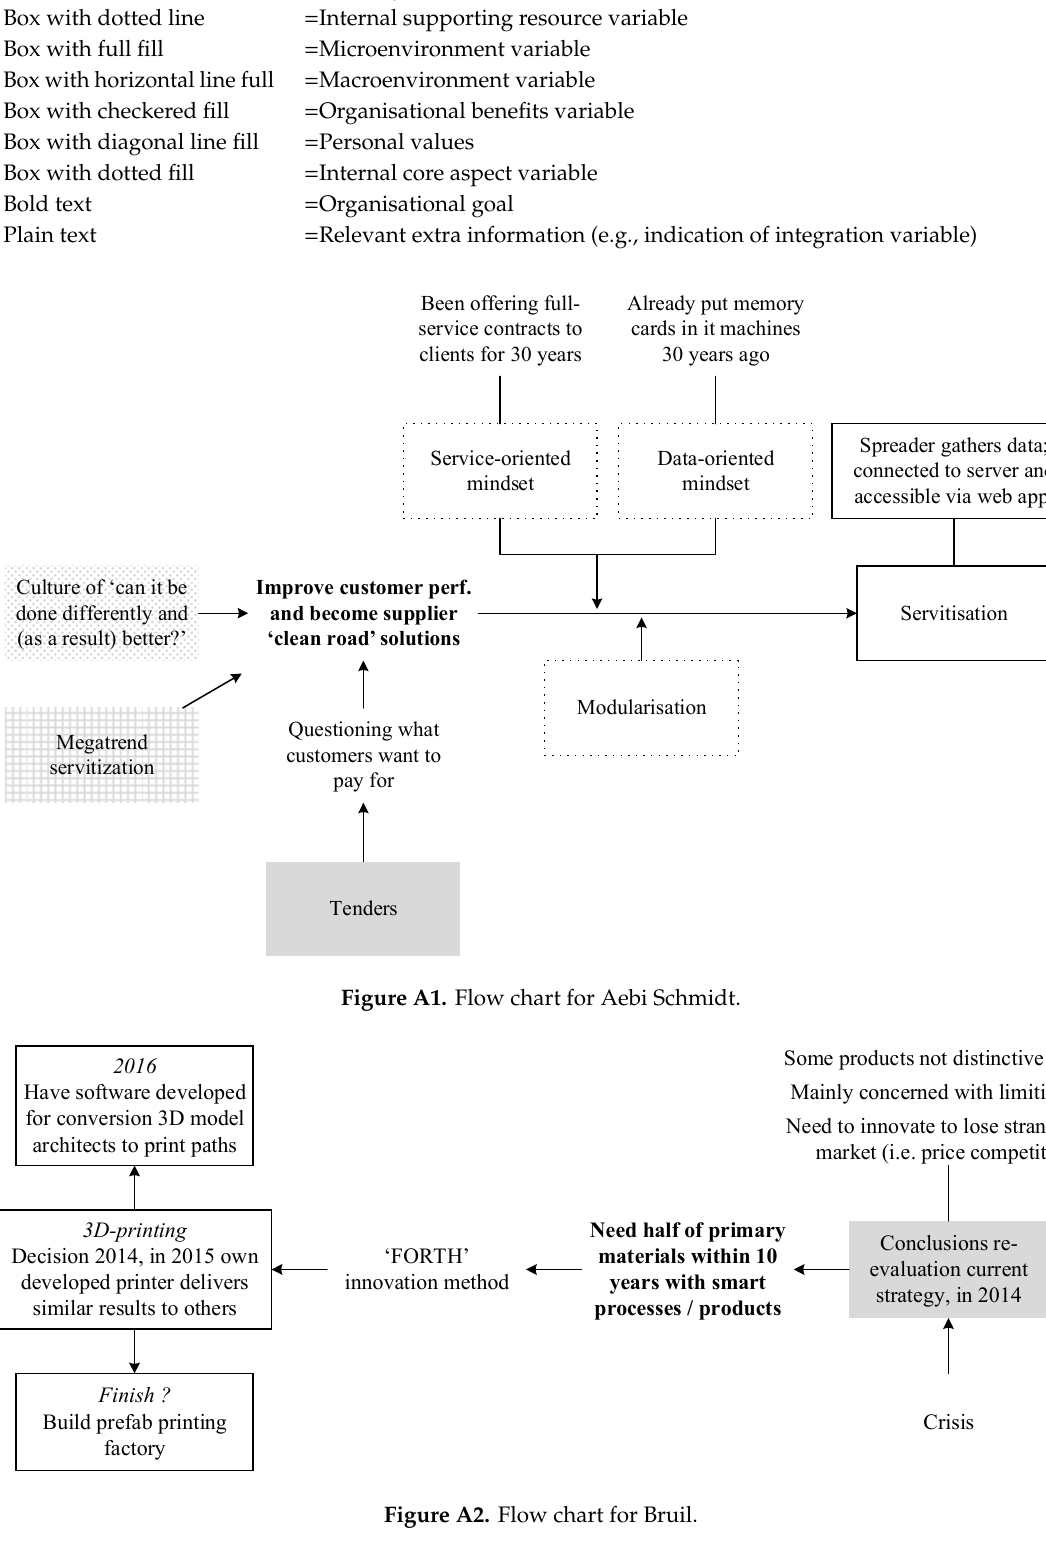
Figure A3. Flow chart for De Cromvoirtse.